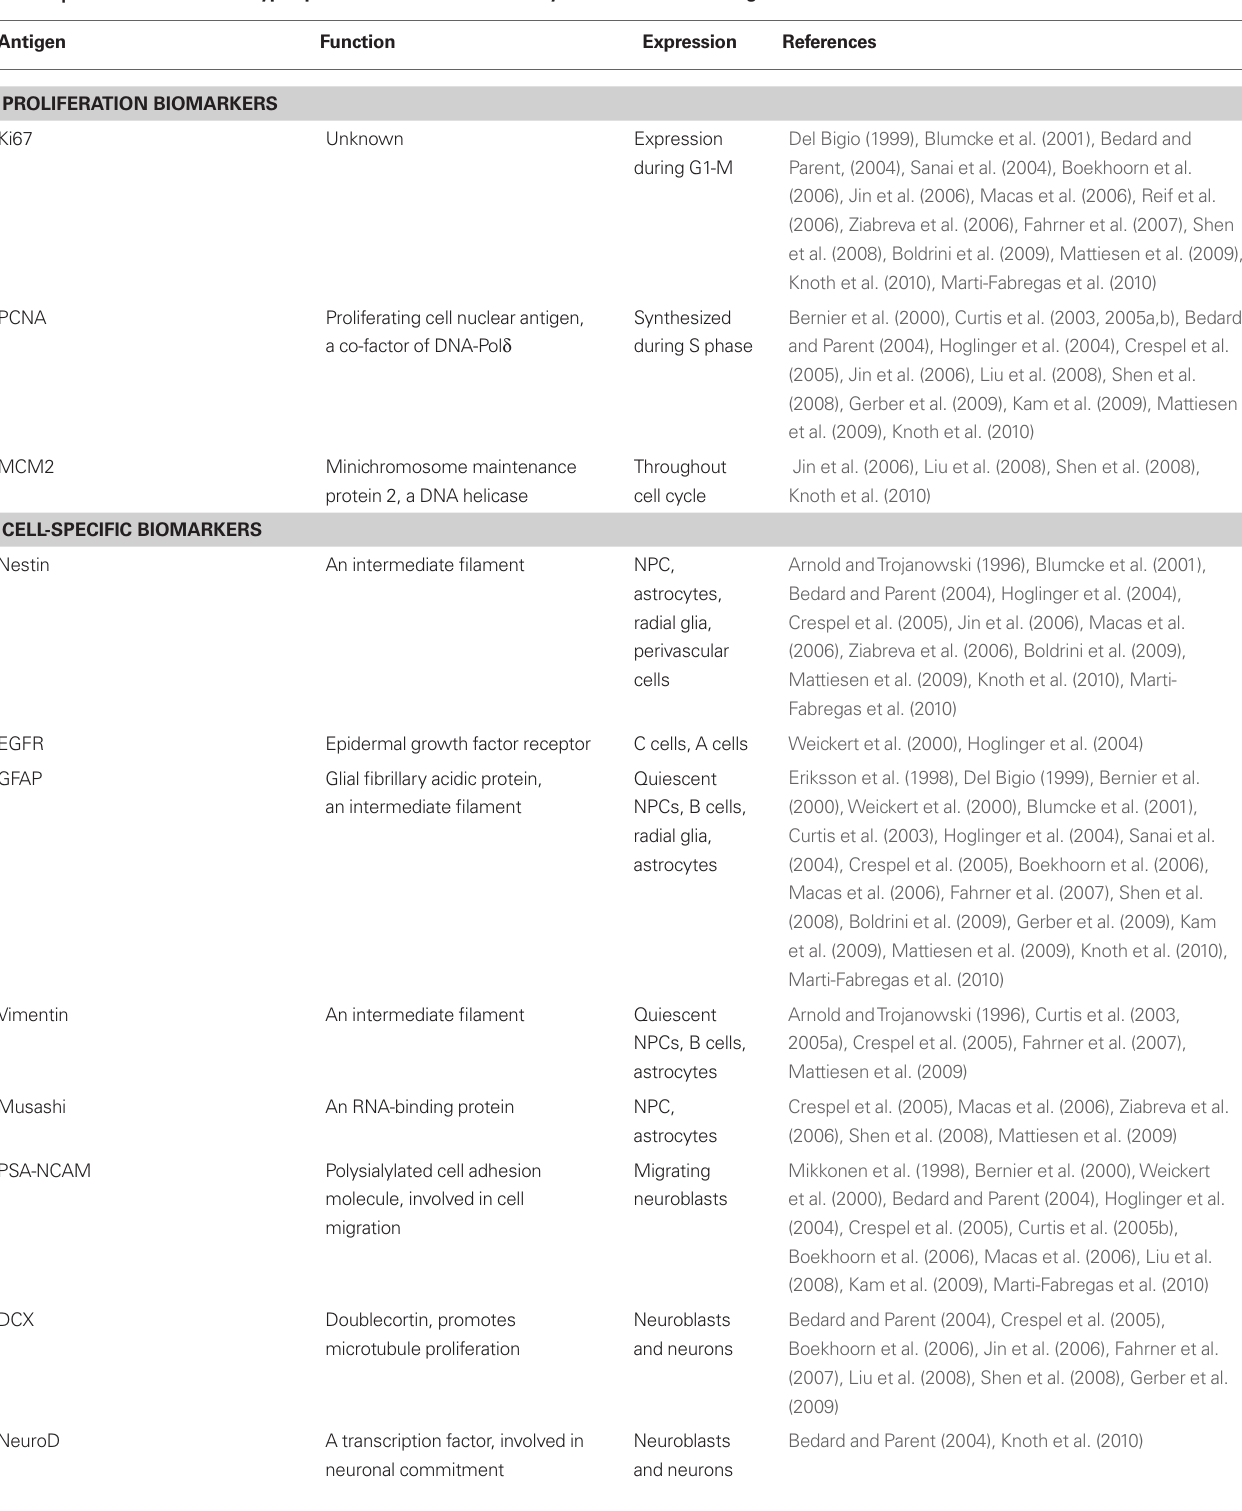
Table 1 | Proliferation and cell-type specific biomarkers commonly used in human neurogenesis